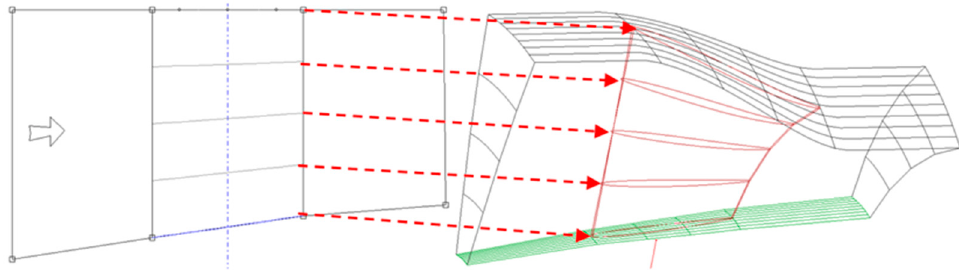
Figure 7. The control layer of the blade.